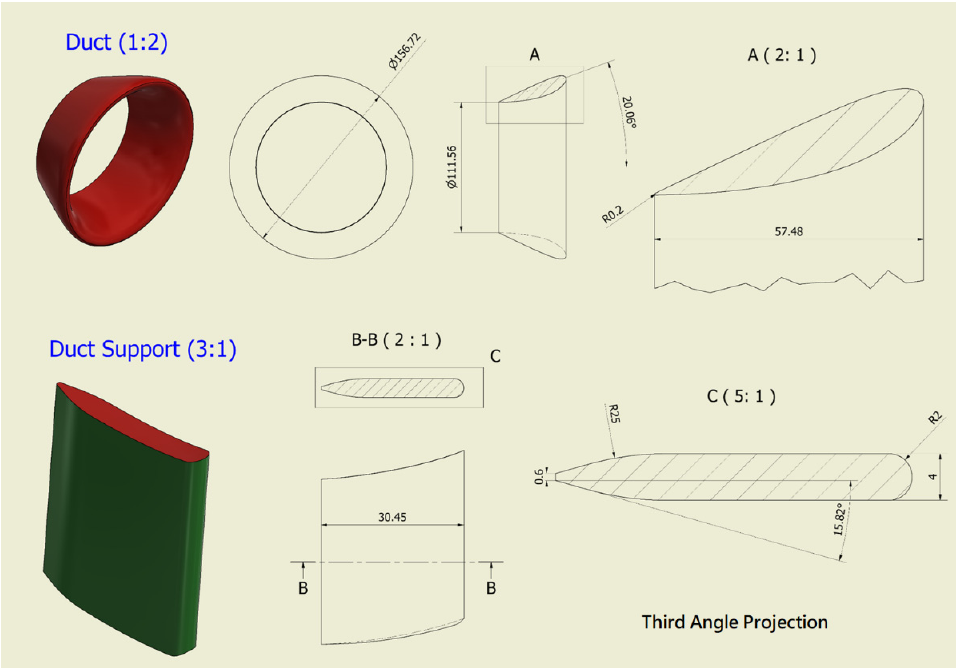
Figure 1. The technical drawing of the original JBC stern duct.